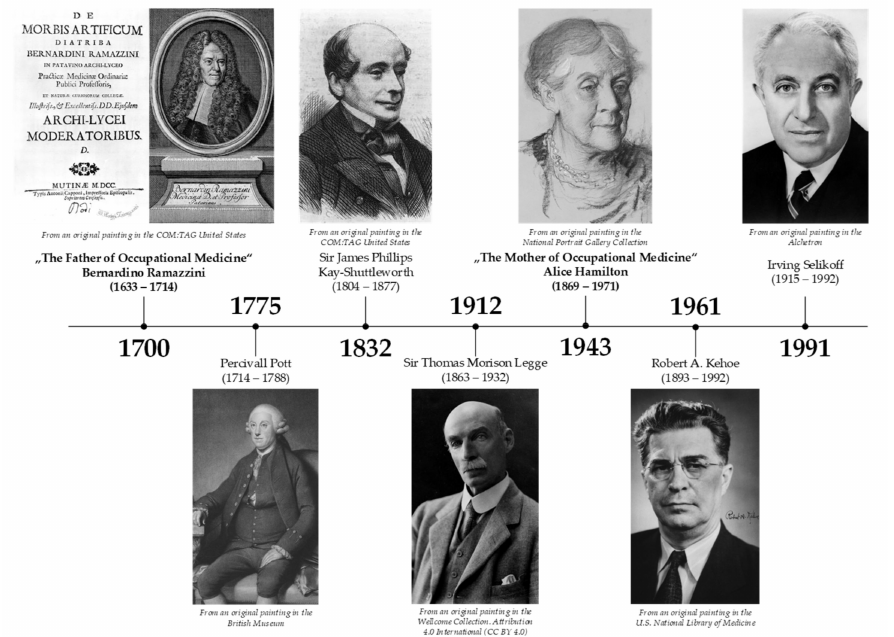
Figure 2. Timeline of the most important reformers of occupational medicine [Source: